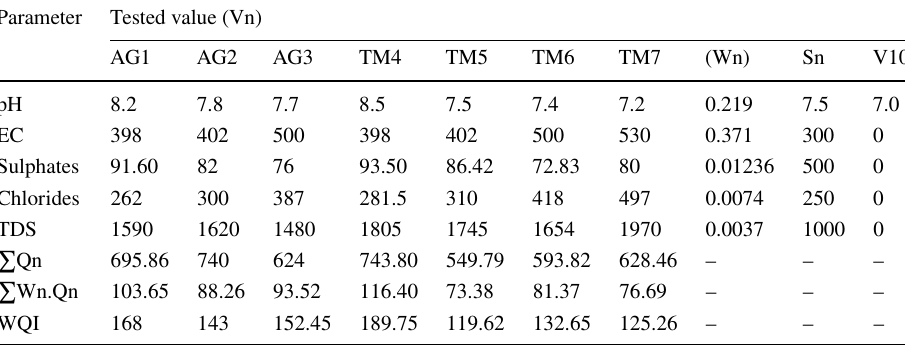
Table 6 Water quality index data for collected industrial